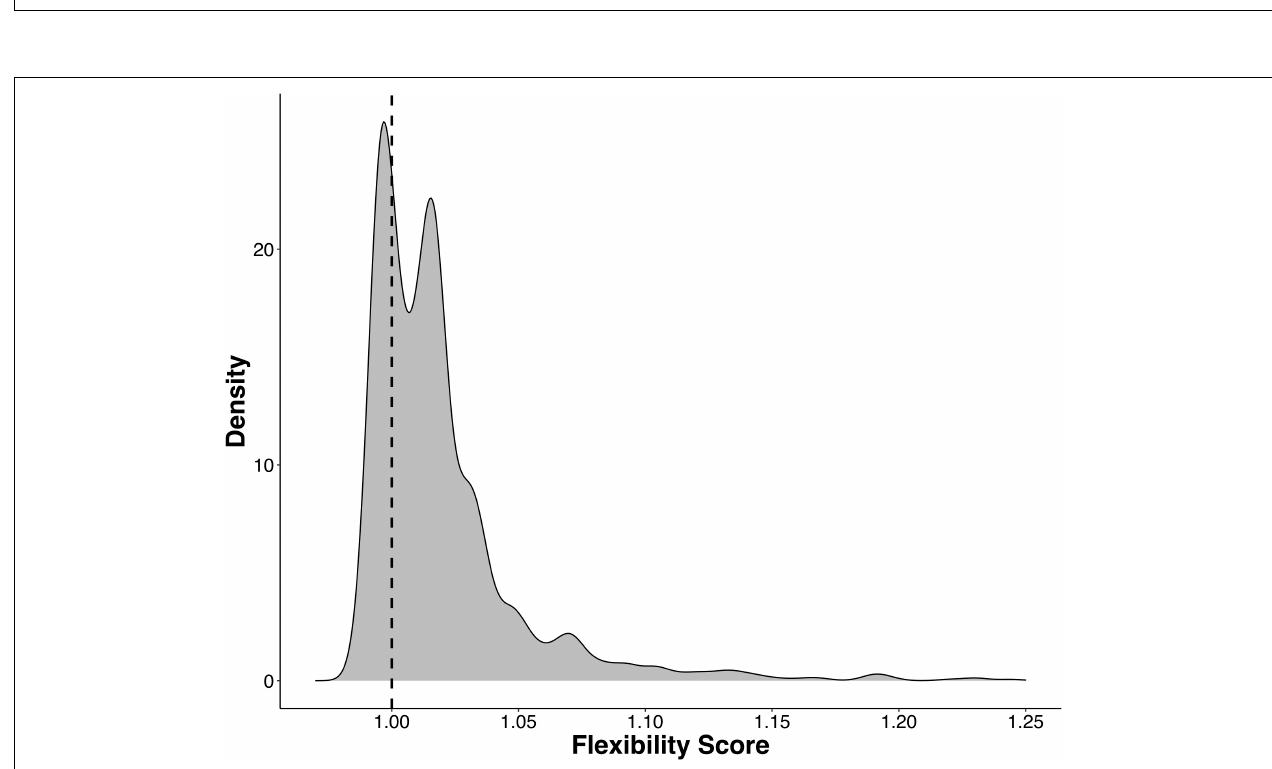
FIGURE 4 | Kernel density plot that shows the distribution of flexibility scores for all ASVs that were detected in more than 1% of the samples ( n = 1375). Hartigan’s dip test for unimodality, p < 2.2e-16, indicates a bimodal distribution. Dashed line denotes a flexibility score of 1.